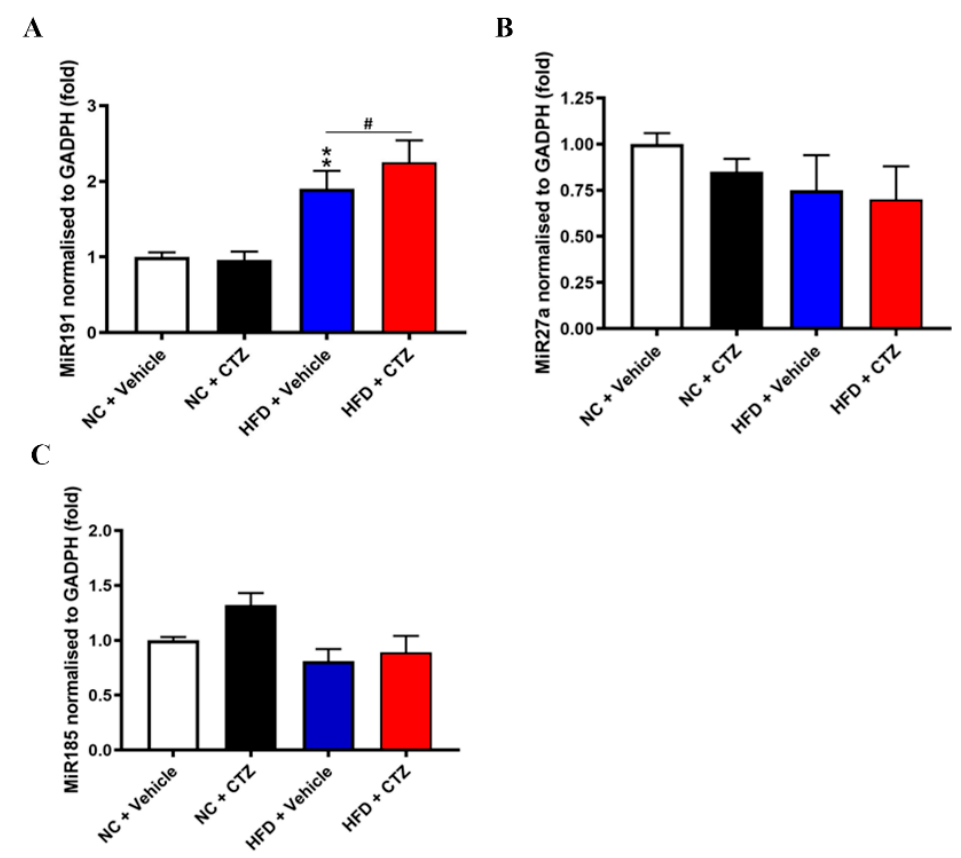
Figure 8. Effects of cilostazol on lipid metabolism-relevant miRNAs in the liver of the mice fed with NC and HFD. Levels of miRNAs were calculated from the results of real-time PCR and the volume of total RNA to compare the simplified absolute quantity in each component. ( A – C ) Quantification of miRNAs levels in the liver of the mice fed with NC and HFD treated with cilostazol or vehicle. ** p < 0.01 versus the NC-fed mice in vehicle-treated group. # p < 0.05, comparison between vehicle and cilostazol treatment in the HFD-fed